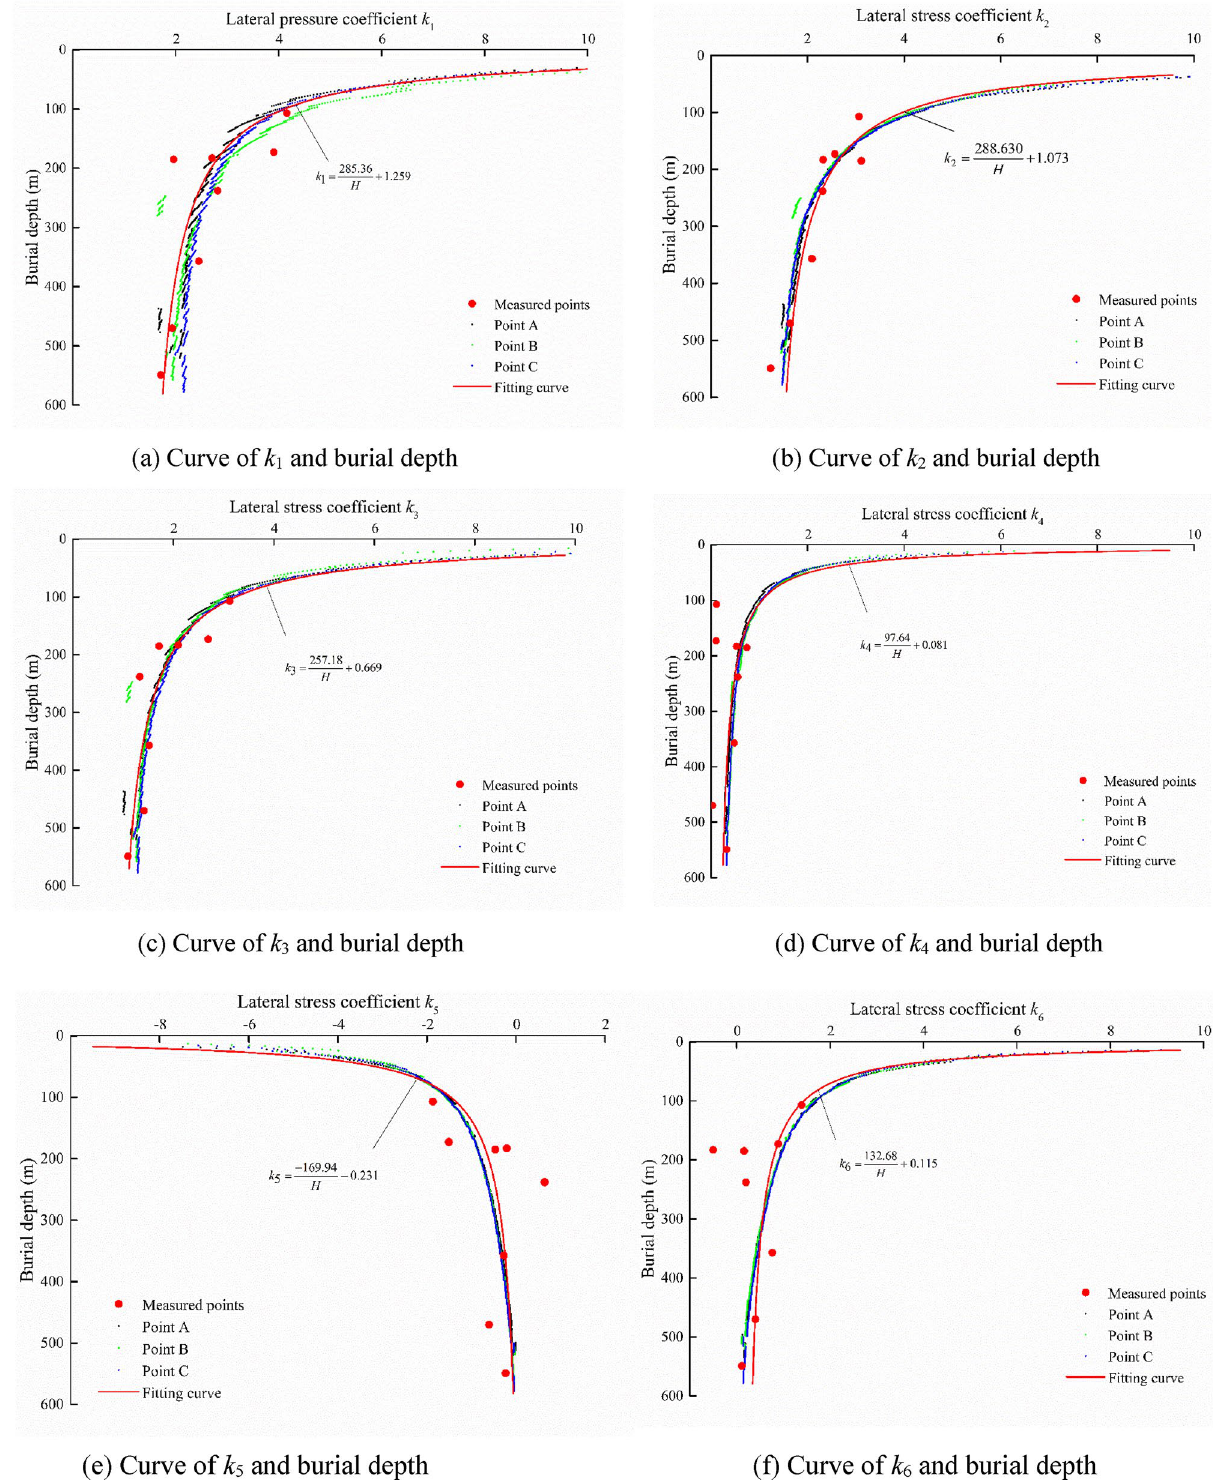
Figure 11. Relationship between k and burial